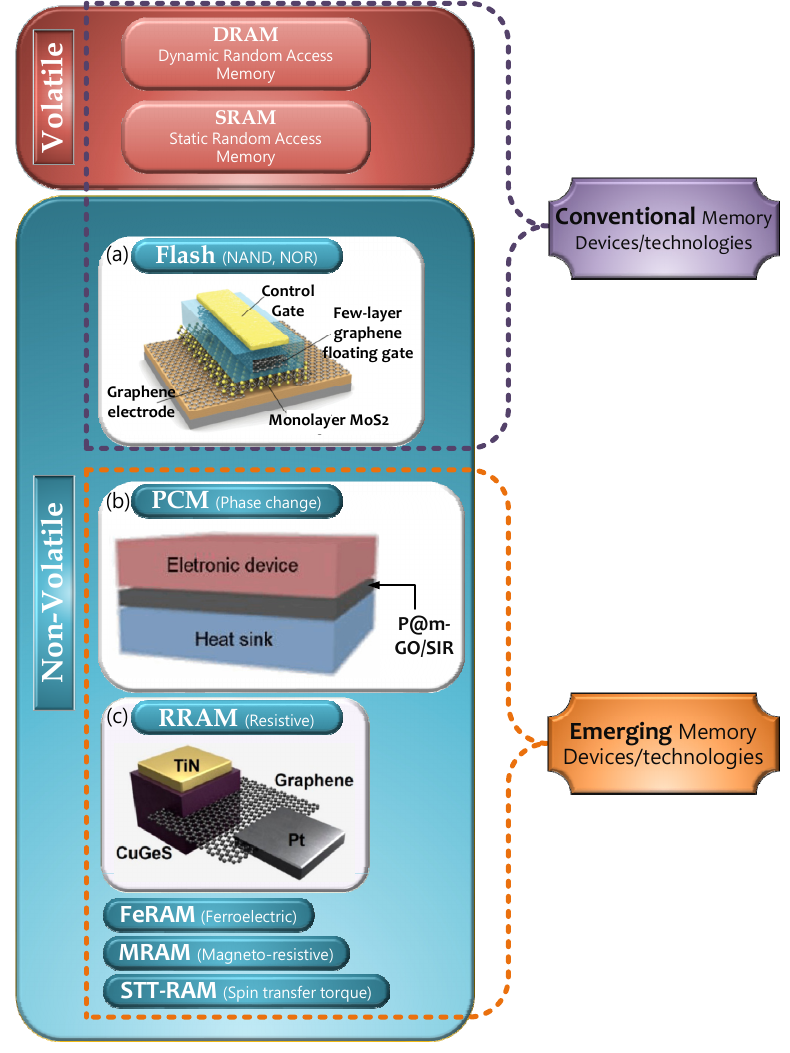
Figure 1. Diagram of conventional and emerging memory devices/technologies, including ( a ) a schematic illustration of flash memory device fabricated with graphene/MoS 2 materials [2] , ( b ) a schematic illustration of flash memory device fabricated with graphene / MoS 2 materials [2], ( b ) a schematic representation showing memory device with phase change materials P@m ‐ GO/SIR [30] , schematic representation showing memory device with phase change materials P@m-GO / SIR [30], and and ( c ) a schematic of graphene ‐ based resistive random access memory (RRAM) device [31] . ( c ) a schematic of graphene-based resistive random access memory (RRAM) device